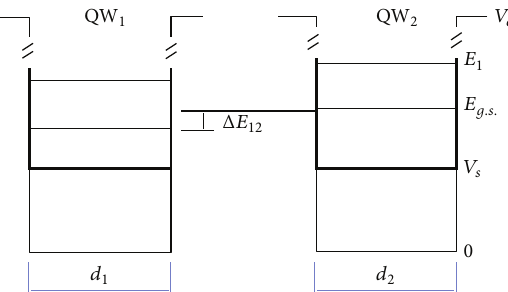
Figure 1: Band gap model for one-dimensional DQW. 𝑑 1 and 𝑑 2 are widths of the QWs, 𝑑 1 ̸= 𝑑 2 . Δ𝐸 12 is the difference between homolog energy levels pertaining to left and right QWs, considered separated. The notations are corresponding to the theoretical model described above. 𝐸 𝑔.𝑠. is ground state energy of an